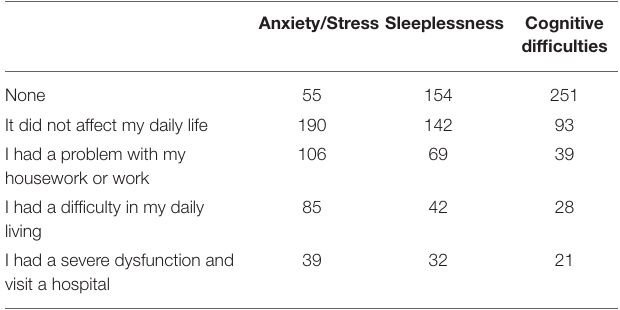
TABLE 2 | Trouble during/after cancer treatment (number of